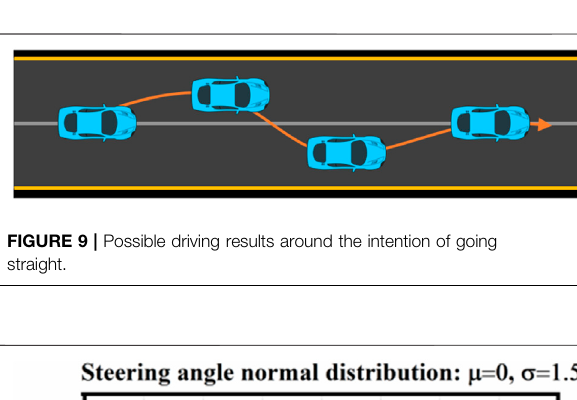
FIGURE8| Entryandexitofvehiclesrelativetoacertaincell. (A) Entersa cell in any direction. (B) Leaves a cell in any direction. De fi nition: L4 = d, with Pright = L 4 + 1 (cid:7) . K ′ + K ′ i (cid:1) 1 L i